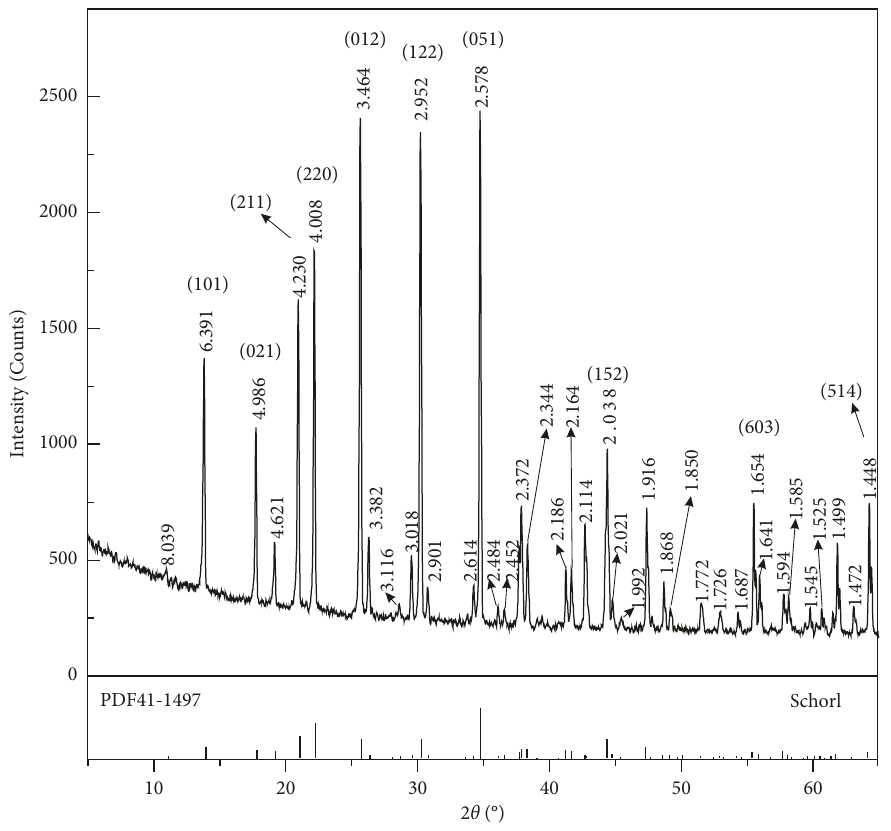
Figure 2: XRD pattern of the tourmaline